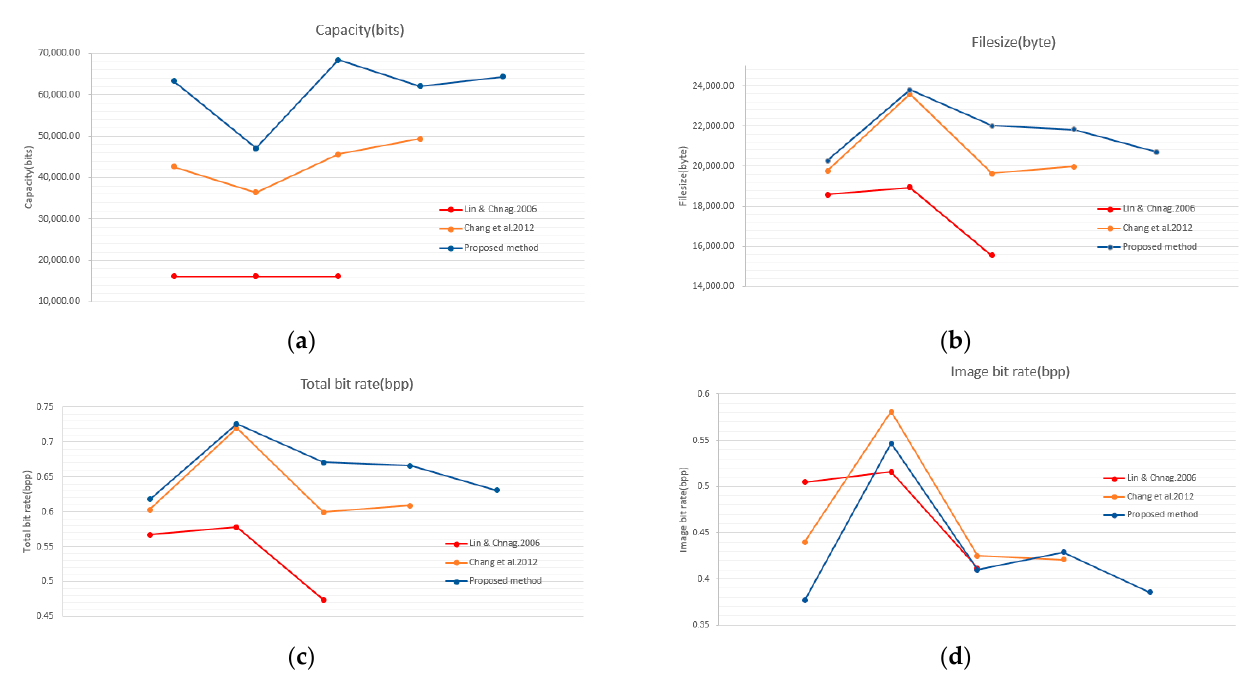
Figure 19. Comparisons with de-clustering RDH schemes. EC ( a ), file size ( b ), total bitrate ( c ), image bitrate ( d ).